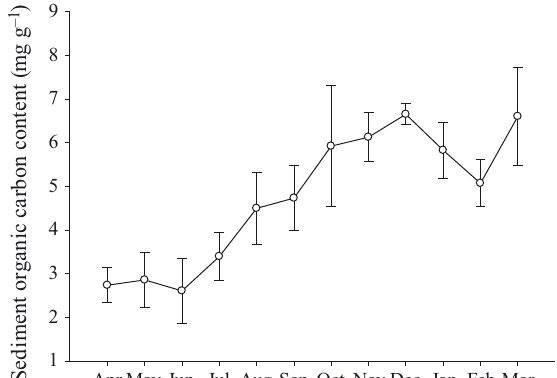
Fig. 2. Monthly variation in sediment organic carbon content of polyculture seawater ponds without feeding. Data are